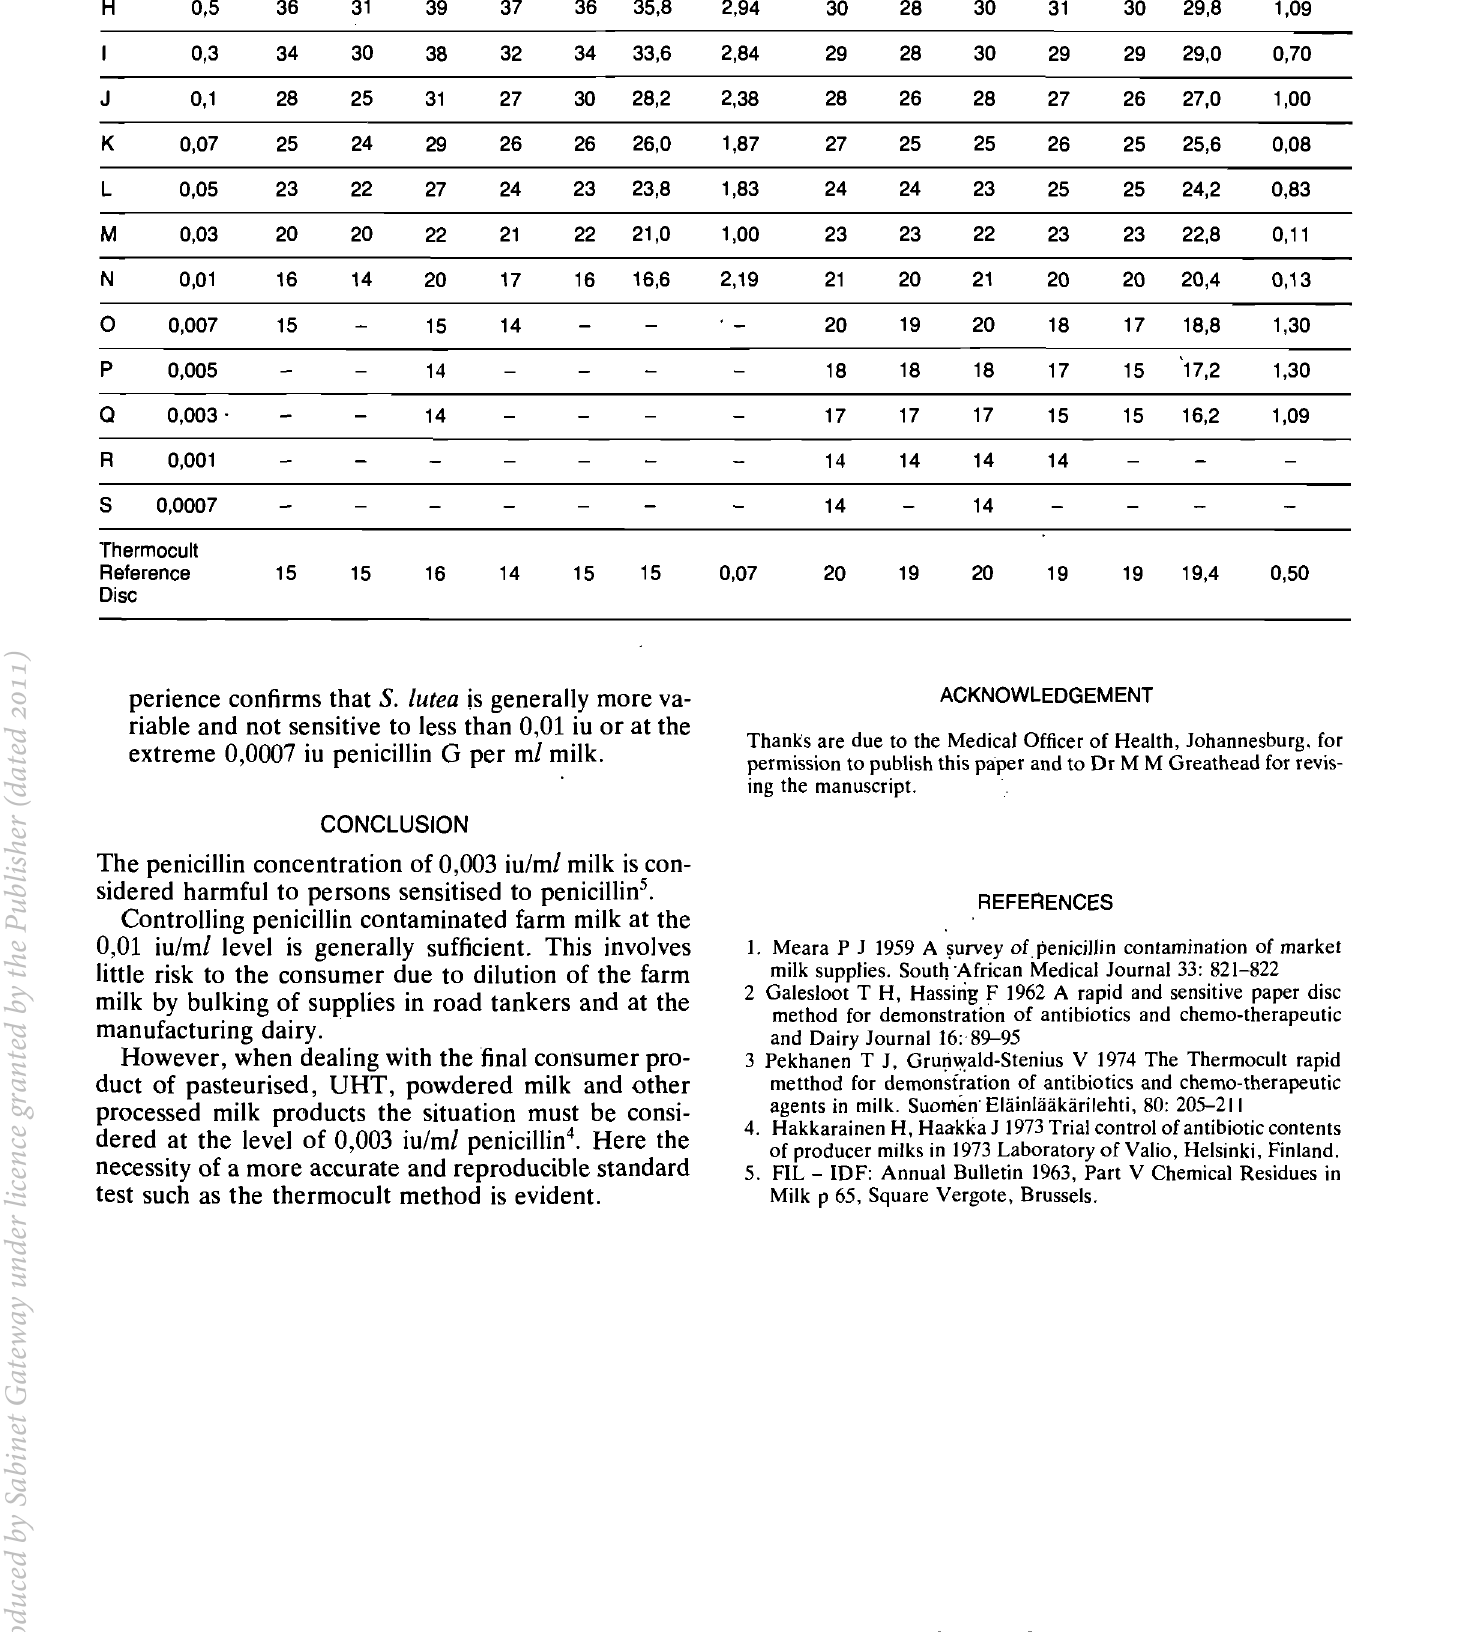
Table 1: COMPARISON OF SIZE OF INHIBITORY ZONES OBTAINED IN THE S. LUTEA AND THERMOCUL T TESTS Sarcina method Penicillin diameter of zone of inhibition in mm dilution in milk iu/ml